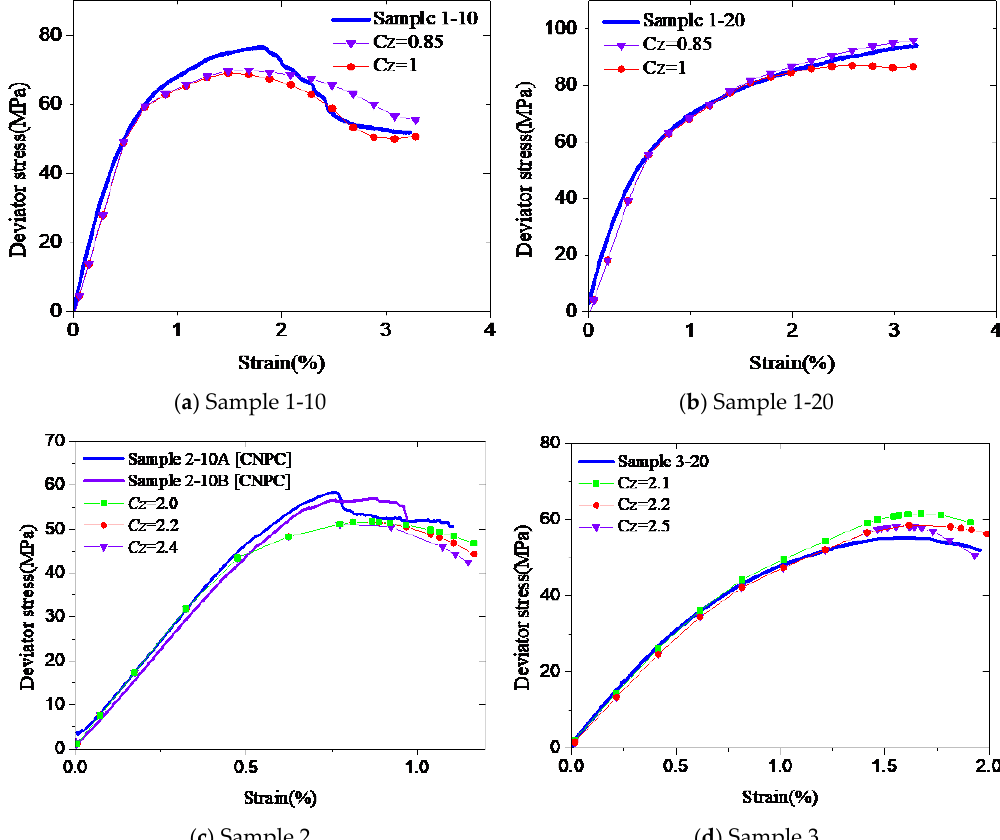
ff ects of C Figure 10. Effects of C Z. ( a ) Sample 1-10, ( b ) Sample 1-20, ( c ) Sample 2, ( d ) Sample 3. Figure 10. E Z. ( a ) Sample 1-10, ( b ) Sample 1-20, ( c ) Sample 2, ( d ) Sample